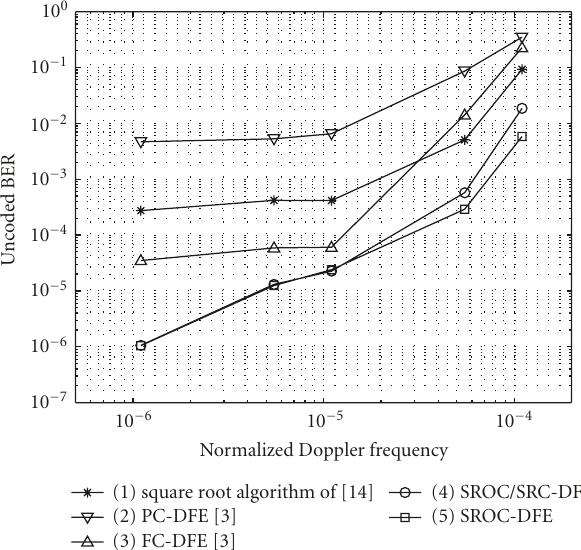
Figure 4: Convergence and tracking performance of equalizers for a 4 × 4 system trained for 512 T s , and operating over a time-varying, frequency-selective MIMO channel at SNR = 16 dB. The normal- ized Doppler frequency is 5 . 5 · 10 − 5 .